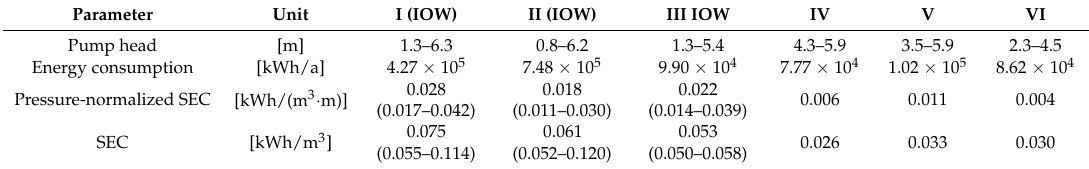
Table 4. Measured SEC of siphon wells and IOW at the Szentendre Island (range of IOW in brackets).